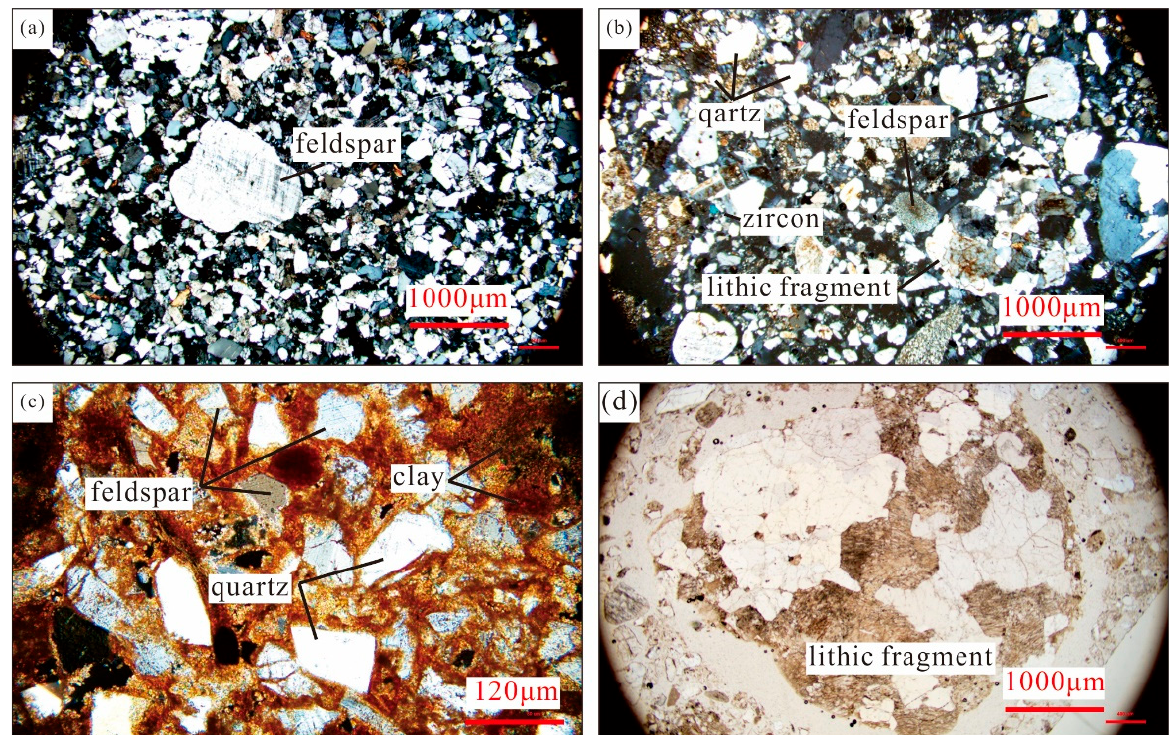
Figure 3. Microphotos of Quaternary sediments that show the texture and mineral assemblages of the quartzose sediments. ( a ) Detrital feldspar grain with subangular morphologies indicating a long distance transport, doubly polarized light (Sample SH12–1). ( b ) Sub-round sand grains showing a poorly sorted, doubly polarized light (Sample SH12–4). ( c ) Angular detrital fragment and clay minerals implying a short distance transport, doubly polarized light (Sample SH12–10). ( d ) Sub-round lithic fragment, plane-polarized light (Sample SH12–12).